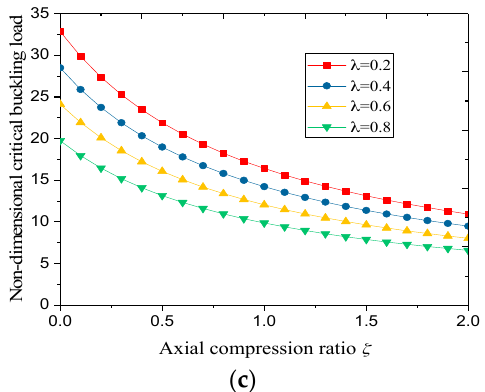
Figure 8. Variation of the non-dimensional critical buckling load with the axial compression ratio ζ of the square FG nanoporous nanoplate ( m = n = 1, h = 5 nm, l a = l b = 50 nm, g = 0.5): ( a ) UD, ( b ) NUD1, ( c ) NUD2.